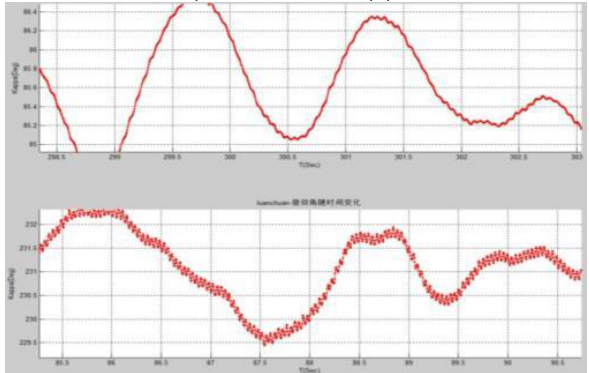
Figure 25 comparison of Kappa data (up: turbine-heli; down: gasoline- heli) In Figure 24 and 25, gentle curve fluctuations with frequencies below 0.5Hz are caused by attitude adjustment of the